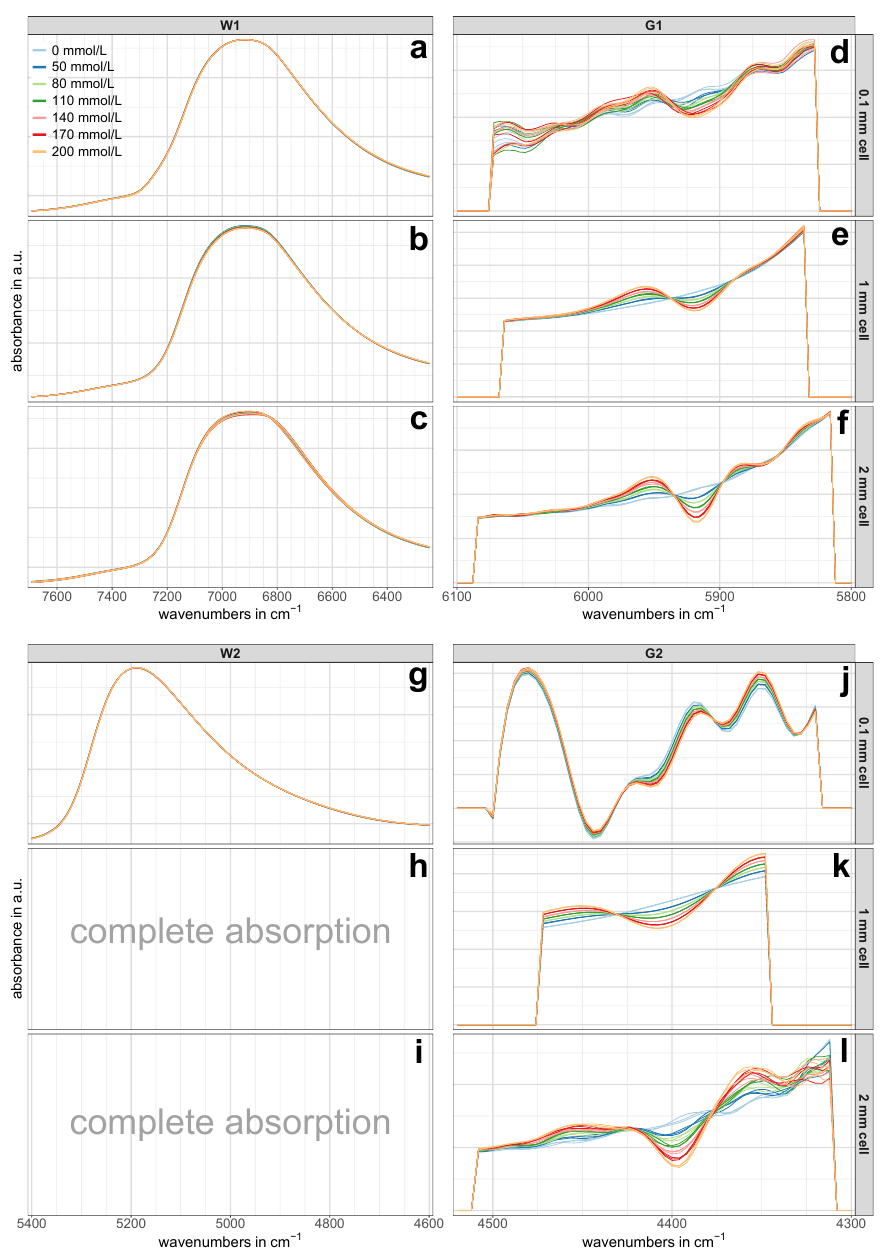
Figure 3. Pre-treated NIR spectra of the calibration set. The spectral regions W1 ( a – c ), W2 ( g ), G1 ( d – f ), and G2 ( j – l ) are shown for all three utilized cell pathlengths separately. Each concentration is represented by three representative NIR spectra (one per batch). No spectra were available in region W2 for the 1 mm and 2 mm cells ( h , i ) due to the complete absorption of the NIR